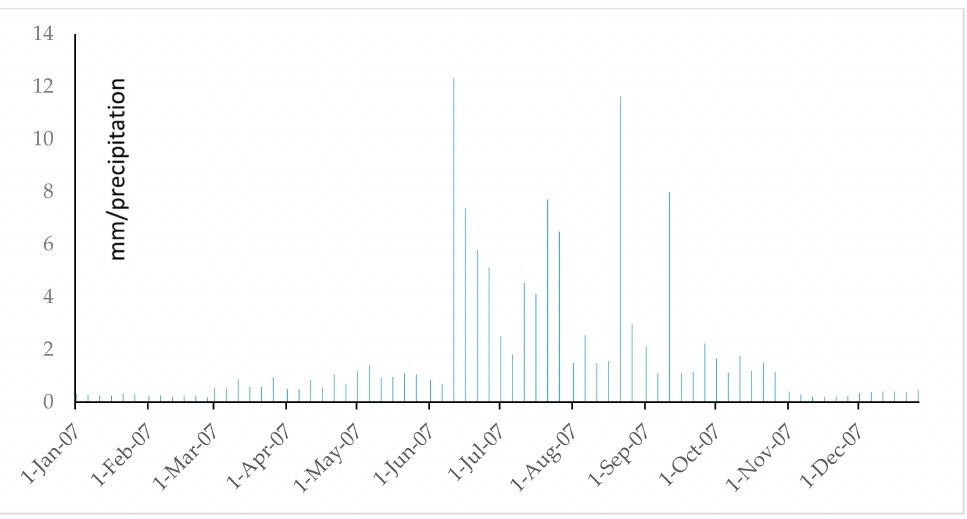
Figure A35. Precipitation of Denko County in 2007.